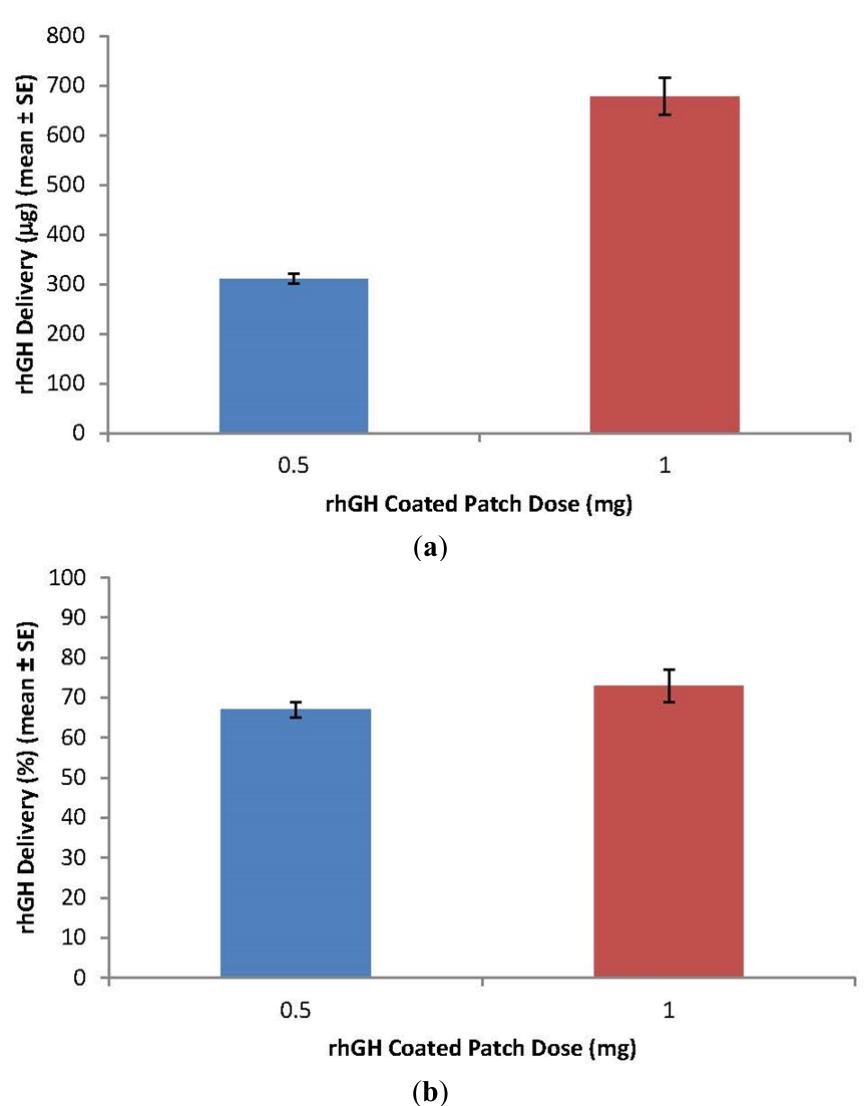
Figure 5. ZP-hGH delivery performance. ( a ) delivery into HGP skin; ( b ) delivery